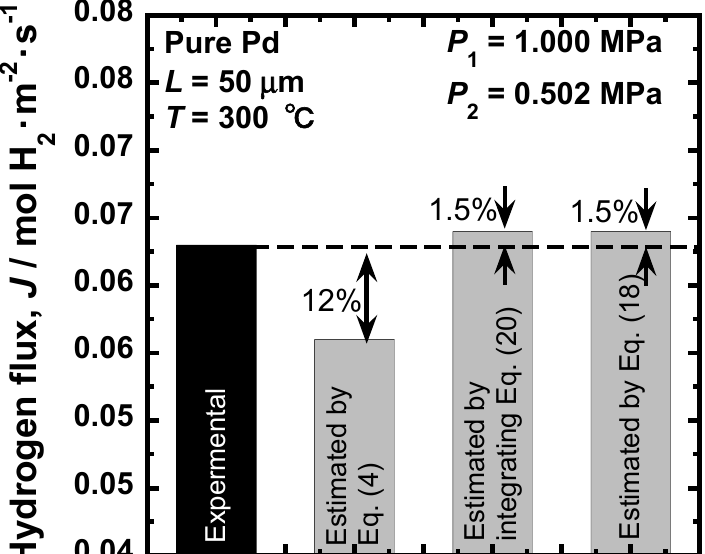
Membranes 2020 , 10 , x FOR PEER REVIEW Figure 6. ( a ) pressure–composition isotherm (PCT curve) for pure Pd at 300 ◦ C and ( b ) change in the Figure 6. ( a ) pressure–composition isotherm (PCT curve) for pure Pd at 300 °C and ( b ) change in the hydrogen flux through pure Pd membrane at 300 ◦ C in Figure 4 replotted as a function of the PCT factor. hydrogen flux through pure Pd membrane at 300 °C in Figure 4 replotted as a function of the PCT factor.